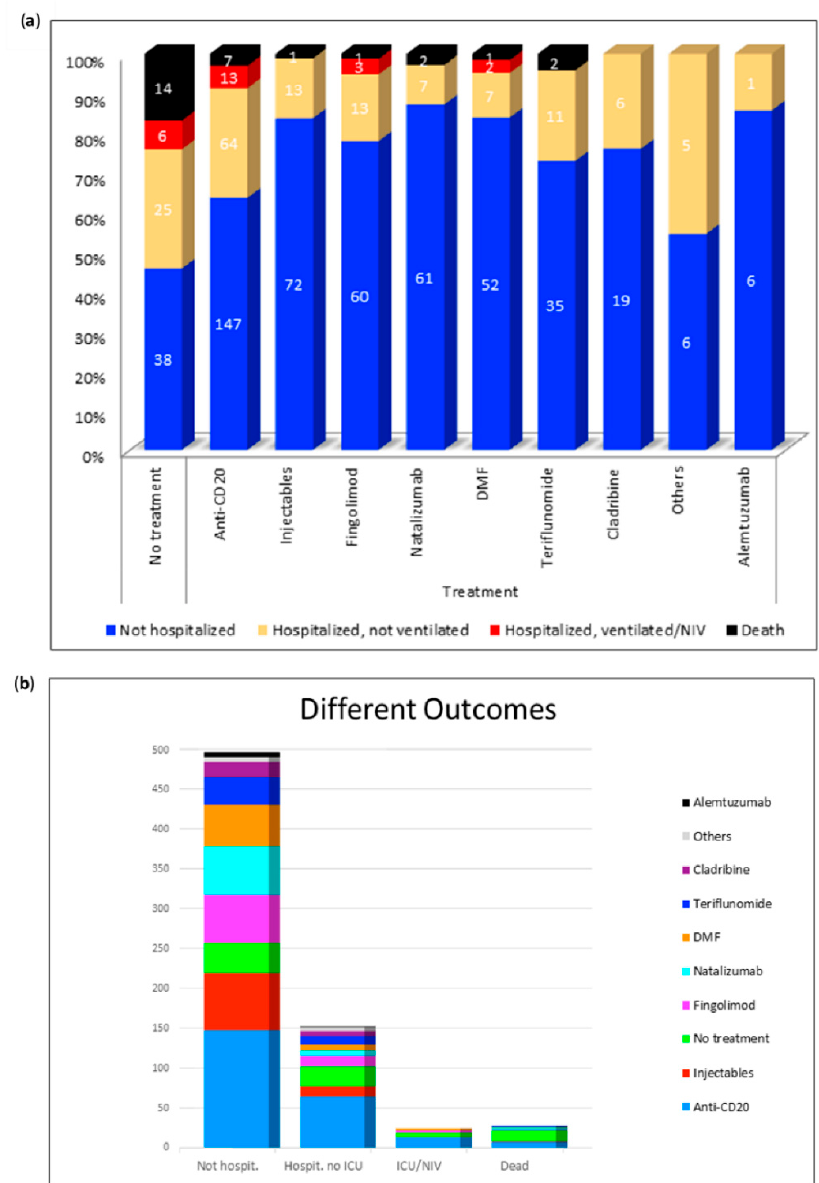
Figure 3. Distribution of the respective outcomes depending on the disease modifying therapies. ( a ) Distribution of di ff erent outcomes per DMT; ( b ) Number of non-hospitalized, hospitalized, ventilated, and deceased patients. DMF: dimethyl-fumarate; Hospit.: hospitalized; ICU: intensive care unit; NIV: non-invasive ventilation. Others: stem cell therapy ( n = 5), immunoglobulins ( n = 4), mycophenolate mofetil ( n = 3), azathioprine ( n = 1), cyclophosphamide ( n = 1), methotrexate ( n =